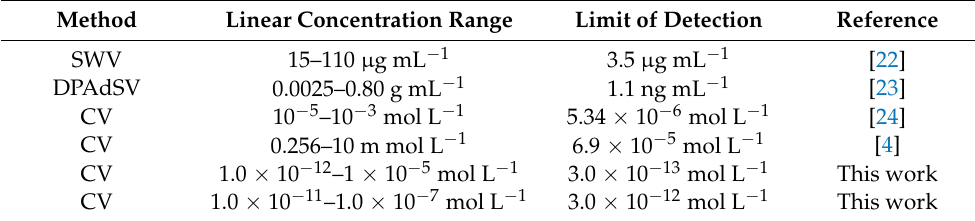
Table 6. Comparison of the new developed method of analysis of thiamine (using 3D sensors) with other methods presented in the